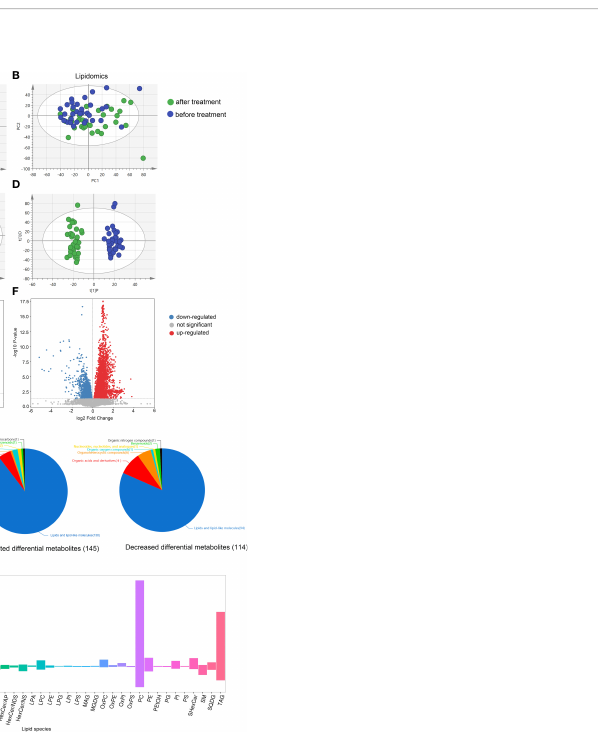
FIGURE 1 Metabolomic and lipidomic pro fi les. (A – D) Principal component analysis (PCA) and orthogonal partial least squares discriminant analysis (OPLS- DA) score plots of the metabolomics and lipidomics data. After-treatment group (green), before-treatment group (blue). (E, F) Volcano diagrams showing all of the identi fi ed metabolites from metabolomics and lipidomics analysis. The x-axis and y-axis were drawn based on the fold change and p values. Each dot represents a metabolite. The larger dots indicate higher VIP value. The increased and decreased metabolites in the after-treatment group are represented by the red and blue dots, respectively, whereas the gray dots represent the unchanged metabolites between two group. (G) Pie charts show total, elevated and decreased differential metabolites. Different colors indicate different classes. (H) Lipidomics bar plot showing the degree of variation in the content of different types of lipids. The y-axis represents the relative percentage change. If the relative percentage change is positive, it means that this super class of lipid is higher in after-treatment group. The x-axis represents the classi fi cation of lipids. Acar, Acylcarnitine; AcylGlcADG, Acylglucuronosyldiacylglycerol; CE, Cholesteryl ester; Cer/ADS, Ceramide alpha-hydroxy fatty acid-dihydrosphingosine; Cer/AP, Ceramide alpha-hydroxy fatty acid-phytospingosine; Cer/AS, Ceramide alpha-hydroxy fatty acid-sphingosine; Cer/EODS, Ceramide Esteri fi ed omega-hydroxy fatty acid-dihydrosphingosine; Cer/EOS, Ceramide Esteri fi ed omega- hydroxy fatty acid-sphingosine; Cer/NDS, Ceramide non-hydroxyfatty acid-dihydrosphingosine; Cer/NS, Ceramide non-hydroxyfatty acid- sphingosine; DAG, Diacylglycerol; DGTS, Diacylglyceryl trimethylhomoserine; FFA, Free fatty acid; FAHFA, Fatty acid ester of hydroxyl fatty acid; GlcADG, glucuronosyldiacylglycerol; GM3, Ganglioside; HBMP, Hemibismonoacylglycerophosphate; HexCer/AP, Hexosylceramide alpha- hydroxy fatty acid-phytospingosine; HexCer/NDS, Hexosylceramide non-hydroxyfatty acid-dihydrosphingosine; HexCer/NS, Hexosylceramide non-hydroxyfatty acid-sphingosine; LPA, Lysophosphatidic acid; LPC, Lysophophatidylcholine; LPE, Lysophosphatidylethanolamine; LPG, Lysophosphatidylglycerol; LPI, Lysophosphatidylinositol; LPS, Lysophosphatidylserine; MAG, Monoacylglycerol; MGDG, Monogalactosyldiacylglycerol;OxPC, Oxidized phosphatidylcholine; OxPE, Oxidized phosphatidylethanolamine; OxPI, Oxidized phosphatidylglycerol; OxPS, Oxidized phosphatidylinositol; PC, Phosphatidylcholine; PE, Phosphatidylethanolamine; PEtOH, Phosphatidylethanol; PG, Phosphatidylglycerol; PI, Phosphatidylinositol; PS, Phosphatidylserine; SHexCer, SulfurHexosylceramide hydroxyfatty acid; SM, Sphingomyelin; SQDG, Sulfoquinovosyl diacylglycerol; TAG,